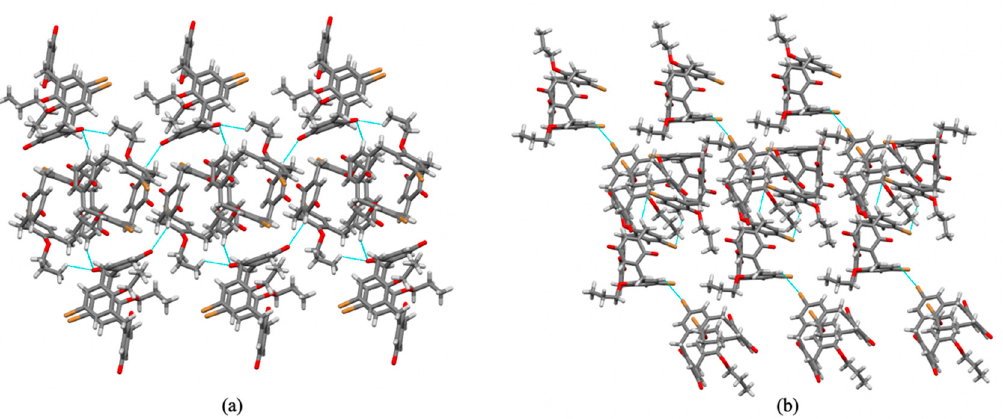
Figure 6. Crystal packing showing ( a ) the C=O---H-C interactions (blue lines) involving 1a and 1b and ( b ) close Br---H-C networks (blue lines) between 1a and 1b .